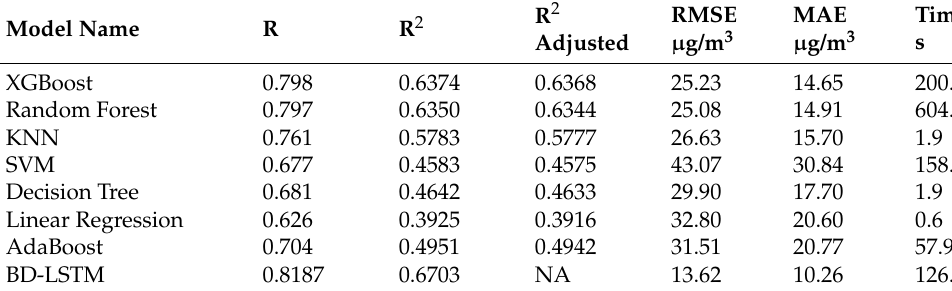
Table 6. Post-monsoon (fall) cross-validation results (October, November, December).